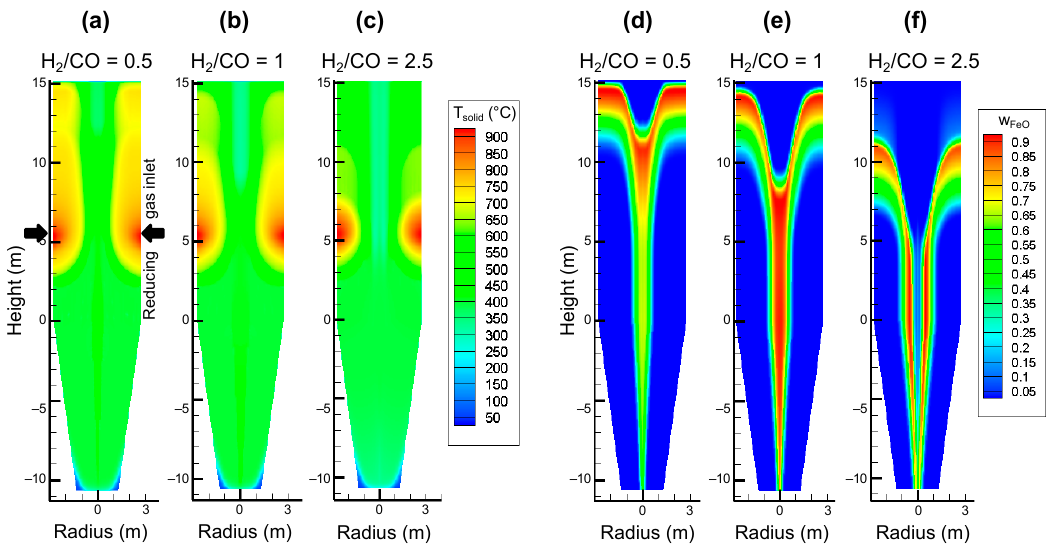
Figure 12. Calculated solid temperature ( a – c ) and iron mass fraction ( d – f ) throughout a shaft furnace fed with different inlet reducing gas compositions: H 2 /CO = 0.5 ( a,d ), H 2 /CO = 1 ( b,e ), H 2 /CO = 2.5 ( c , f ), the other species being CH 4 (9%), H 2 O (4%) and CO 2 (2%).